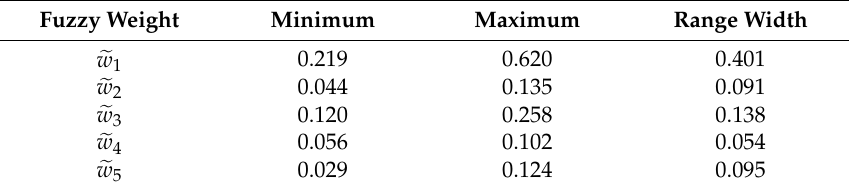
Table 2. The minimums, maximums, and range widths of the fuzzy weights.